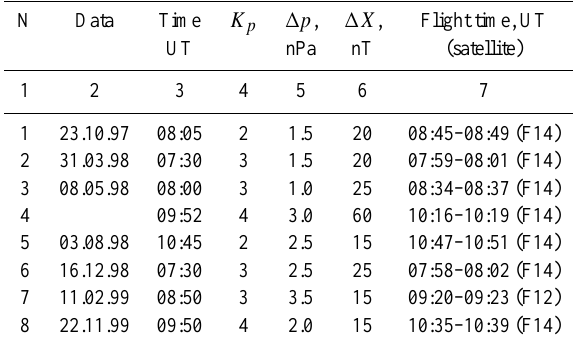
Table 2. List of the sudden impulses which have not excited ULF activity to be observed on the